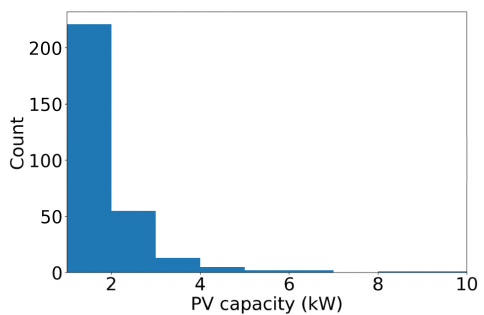
Figure 5. PV capacity distribution histogram in